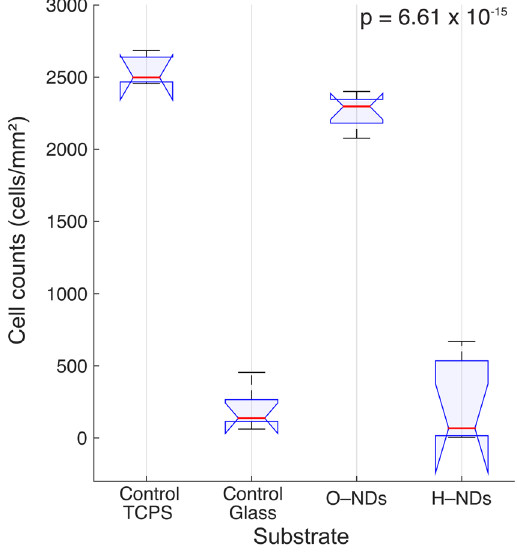
Figure 4. ANOVA analysis for hNSCs counted on Control TCPS, Control Glass, O–NDs and H–NDs (with protein coating) displayed as a boxplot; n = 6–8 images used for each substrate. Red horizontal lines represent the medians per substrate group in (cells/mm 2 ), blue horizontal lines represent upper and lower quartiles, with blue notches signify a 95% confidence interval around the median. Black lines show the range of cell counts. Multicomparison analysis shows that Control TCPS and O–NDs are not statistically distinguishable, neither